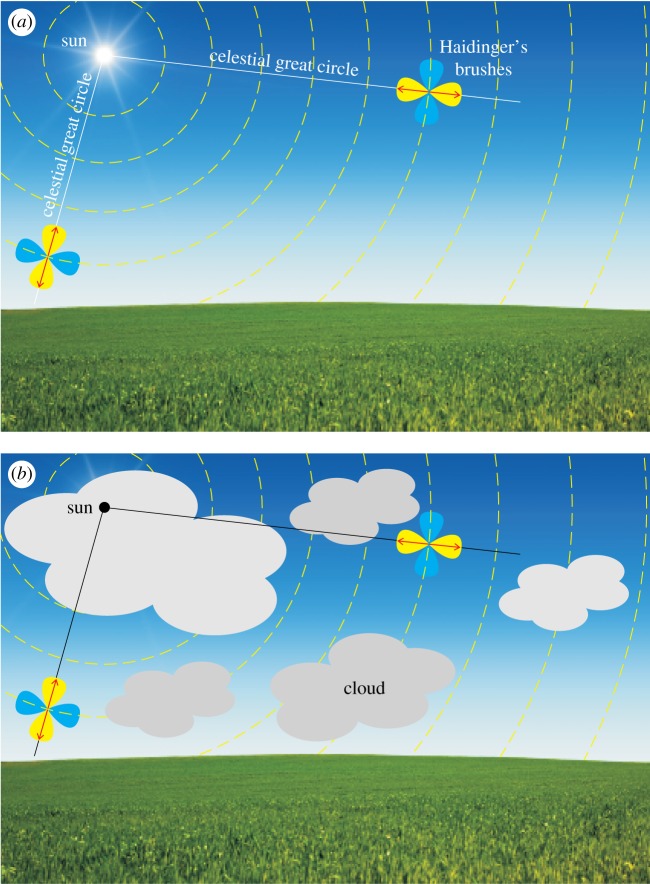
Principle of the sky-polarimetric Viking navigation on the basis of Haidinger's brushes. (a) Clear sky. (b) Cloudy sky. Yellow bars: local direction of polarization of skylight. Red double-headed arrow: axis of mirror symmetry of the yellow Haidinger's brush being perpendicular to the direction of polarization. The long axis of the blue Haidinger's brush is parallel to the direction of polarization. Owing to Rayleigh scattering of sunlight in the atmosphere, the celestial great circle passing through the observed sky point parallel to the yellow Haidinger's brush crosses the sun.